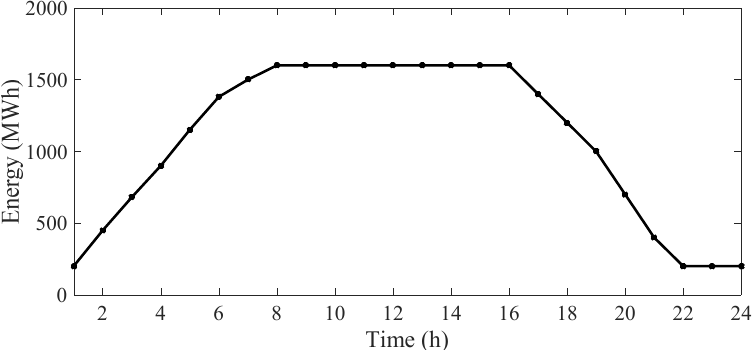
Figure 7. Energy profile of energy storage systems (ESSs).